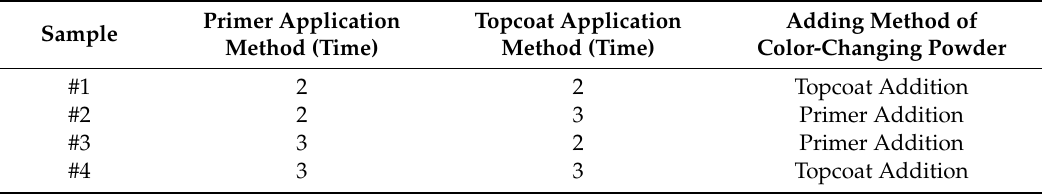
Table 1. Orthogonal experiment schedule of coating technology.